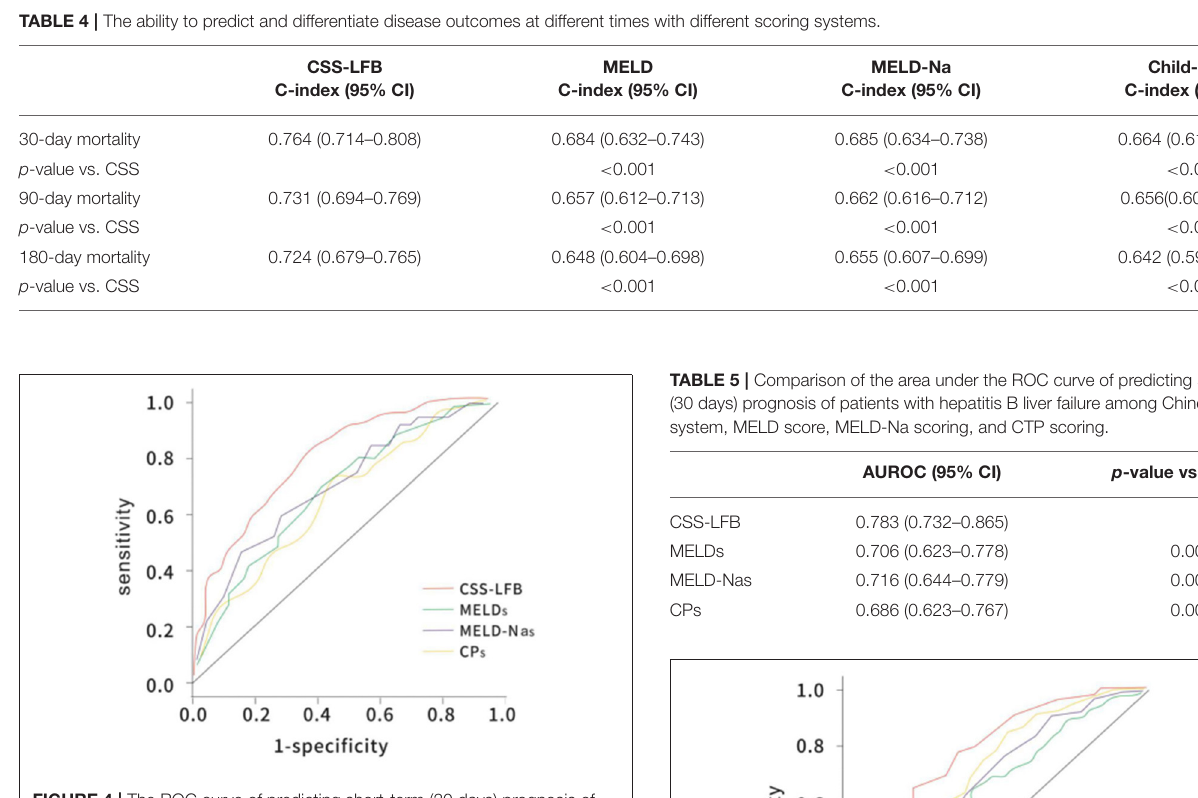
FIGURE 4 | The ROC curve of predicting short-term (30 days) prognosis of patients with hepatitis B liver failure among the Chinese scoring system, MELD score, MELD-Na scoring, and CTP scoring. CTP, Child-Turcotte-Pugh; MELD, model for end-stage liver disease; ROC, receiver operating characteristic.